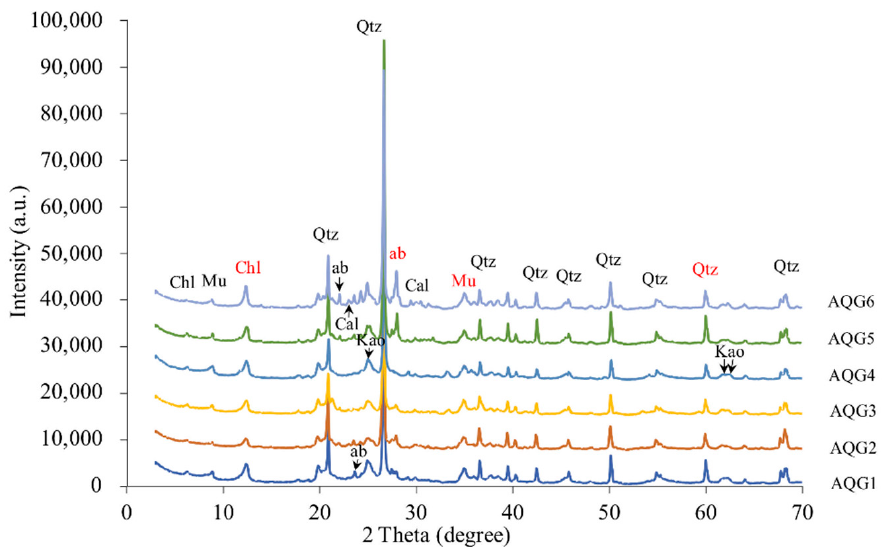
Figure 2. X-ray diffraction patterns for the six sampled rock layers. Chl—chlorite; ab—albite; Mu—muscovite; Qtz—quartz; Cal—calcite; Kao—kaolinite. The red font is mainly described in the text.